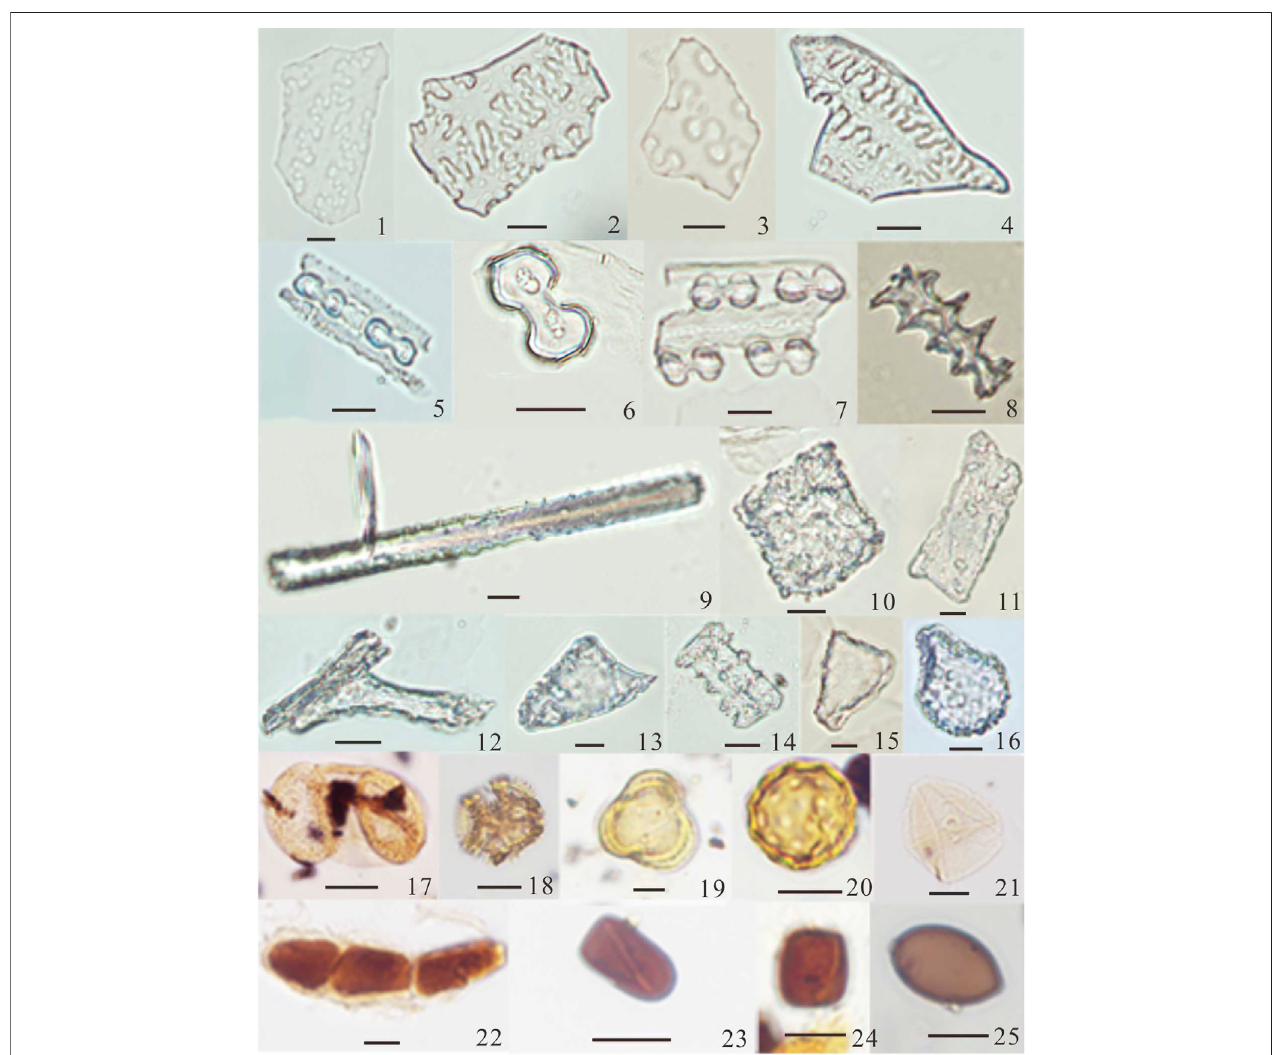
FIGURE 3| Phytoliths, pollen and fungal spores from the ZKG section. 1, 2, 4, Broomcorn millet husk; 3, Foxtail millet husk; 5-7, Bilobate; 8, Elongate dendritic; 9, Elongate psilate; 10, Square; 11, Rectangle; 12, “ Y ” type; 13, Acicular hair cell; 14, Tooth type; 15, Fusiform; 16, Cuneiform bulliform; 17, Pinus; 18, Compositae- Taraxacumtype 19, Artemisia; 20, Chenopodiaceae; 21, Poaceae; 22 – 24, Sporormiella; 25, Sordaria (black lines indicate 10 μ